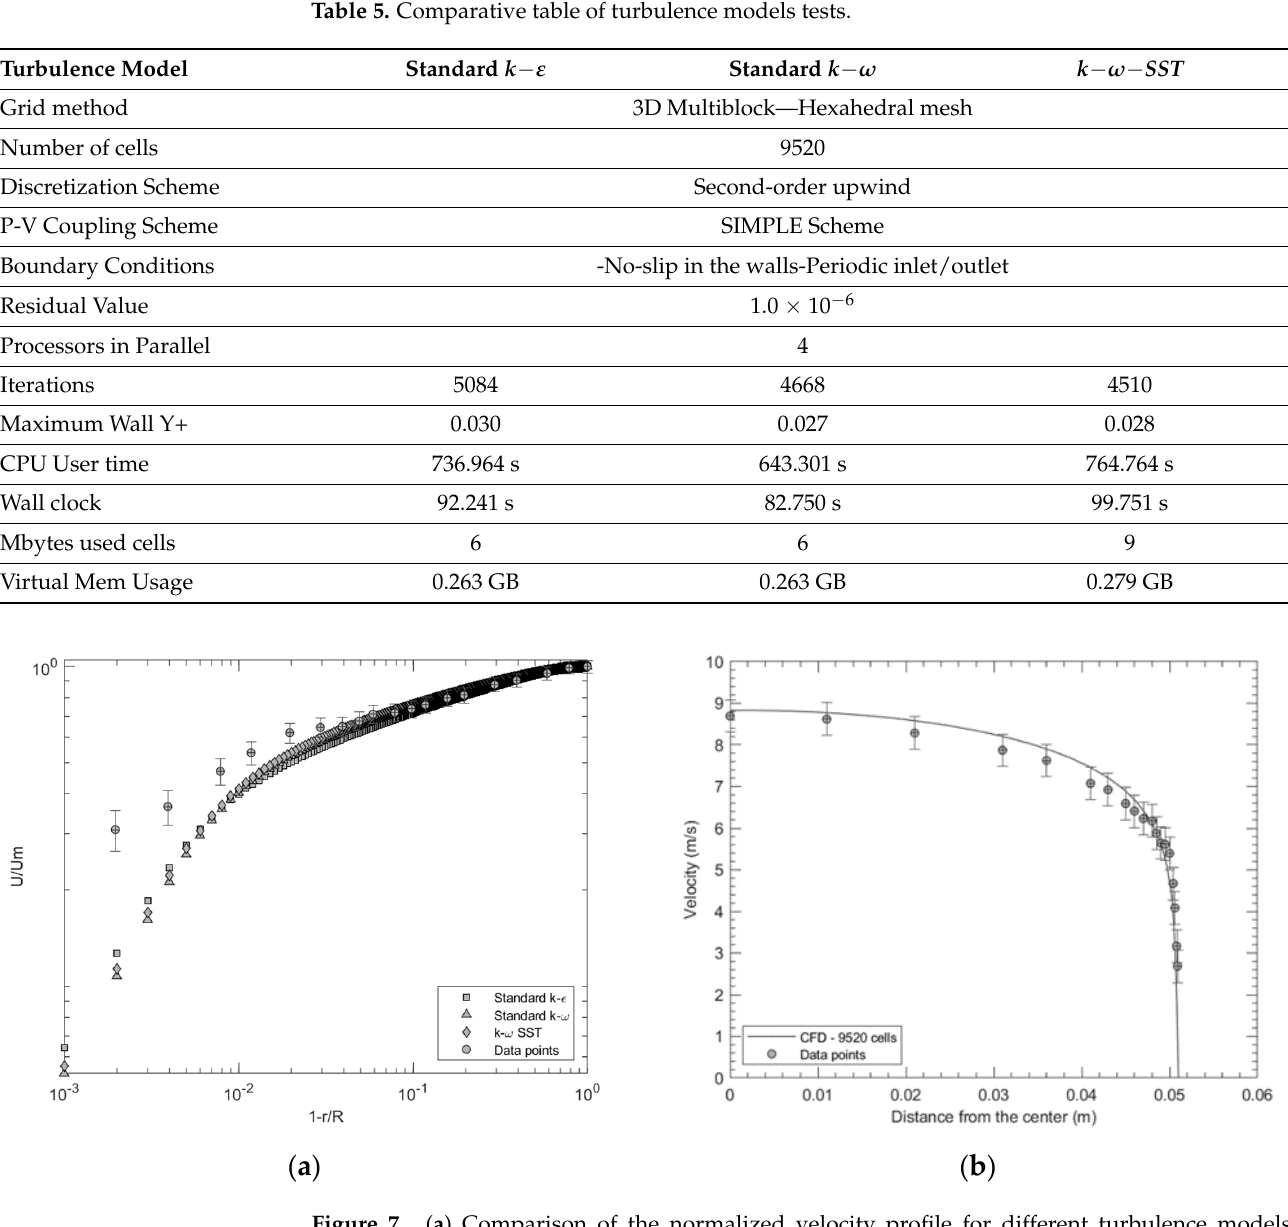
( b ) Figure 8. Velocity profiles comparison between experimental and CFD results: ( a ) Normalized ve- locity versus the dimensionless distance from the pipe wall on logarithmic axes; ( b ) Dimensionless velocity U+ versus the dimensionless distance from the pipe wall Y+. 3.4.2. Wall Shear Comparison As with the velocity profile distribution, a comparison of the theoretical, experi- mental and computational data for the shear stress distribution across the pipe surface, as